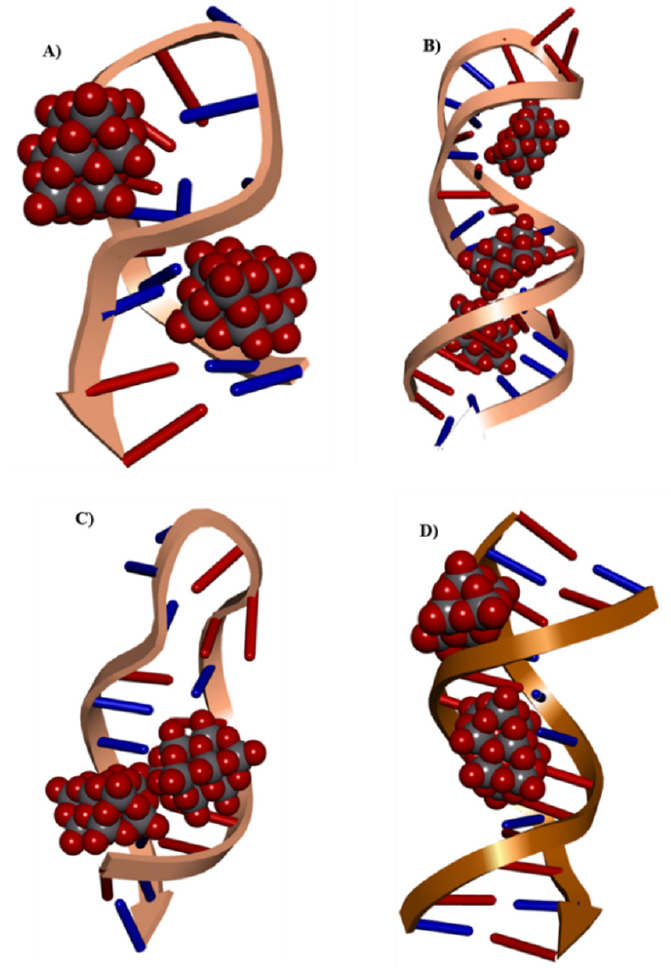
Figure 11. Docked structures of top molecular poses for: ( A ) decavanadate-pre-miRNA, ( B ) decavanadate-let-7 miRNA, ( C ) decavanadate-lncRNA, and ( D ) decavanadate-DNA. Vanadium atoms are represented as grey spheres. Red spheres represent oxygen atoms. Blue bars represent purine bases and red bars pyrimidine bases. Table 6. Docking results. Binding energies for the decavanadate anion best molecular poses with miRNAs and DNA. Binding Energies Compound Target H Bonds Interactions (Kcal/mol)